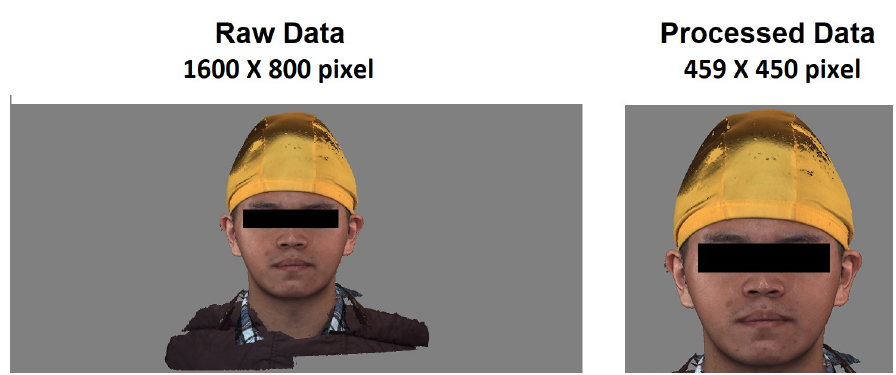
Figure 1. Original picture and processed